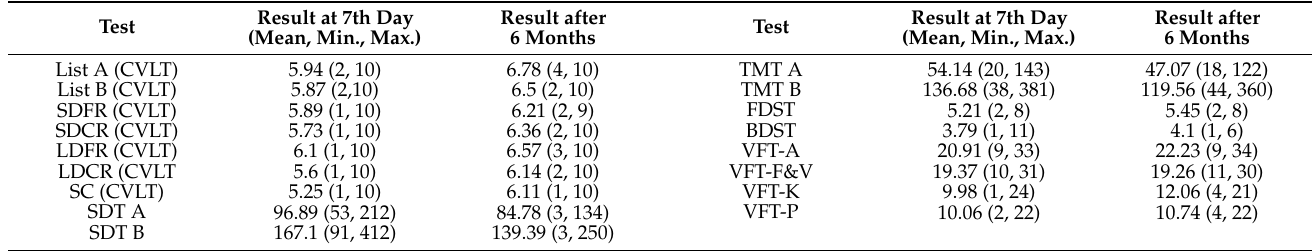
Table 6. Results of neuropsychological tests performed on the 7th day and after 6 months.